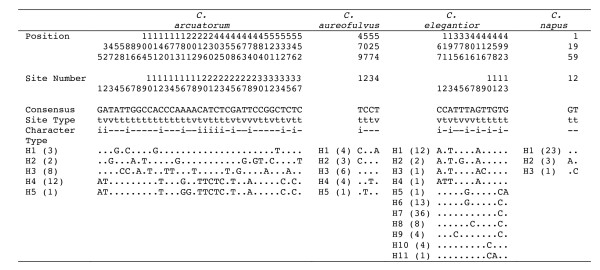
Distribution of polymorphic sites after removing indels and recombination blocks in the ITS haplotypes of calochroid species. t, transitions; v, transversions; i, phylogenetically informative sites; -, uninformative sites.